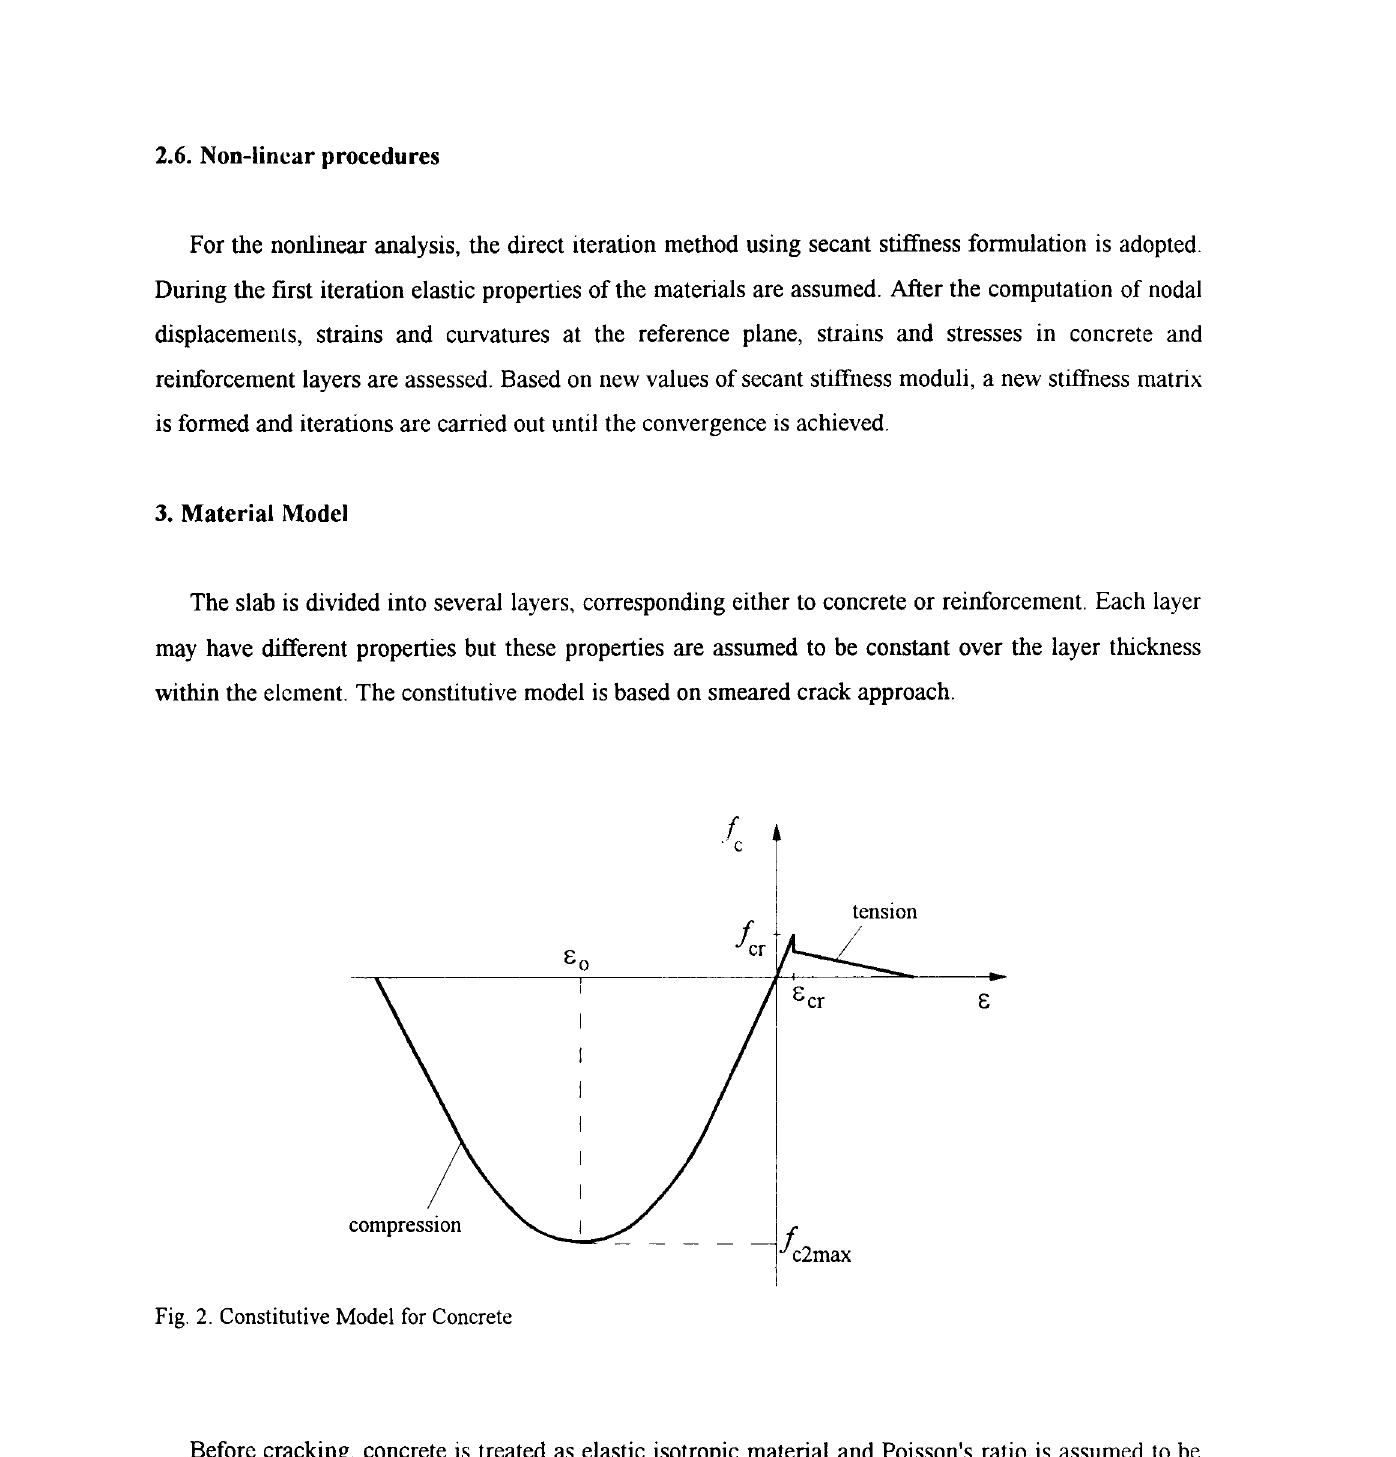
Fig. 2. Constitutive Model for